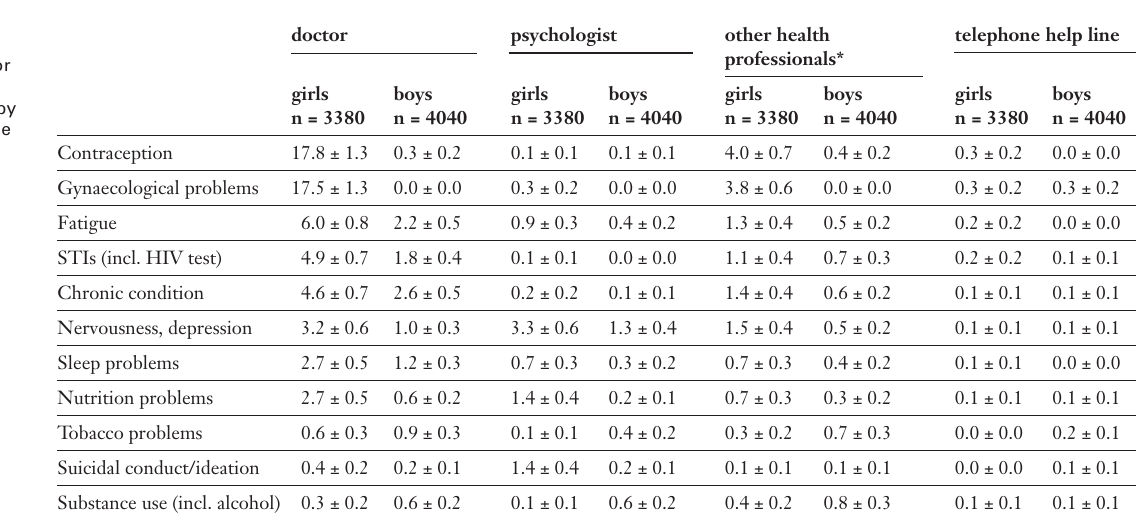
Different reasons for consulting health care professionals by adolescents over the last 12 months.